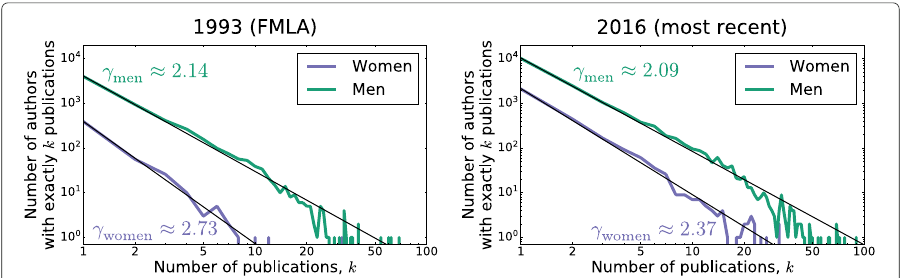
disproportionately rare. We quantified this effect by measuring the power-law exponent of the degree distributions, and found a significantly steeper slope for women (Fig.